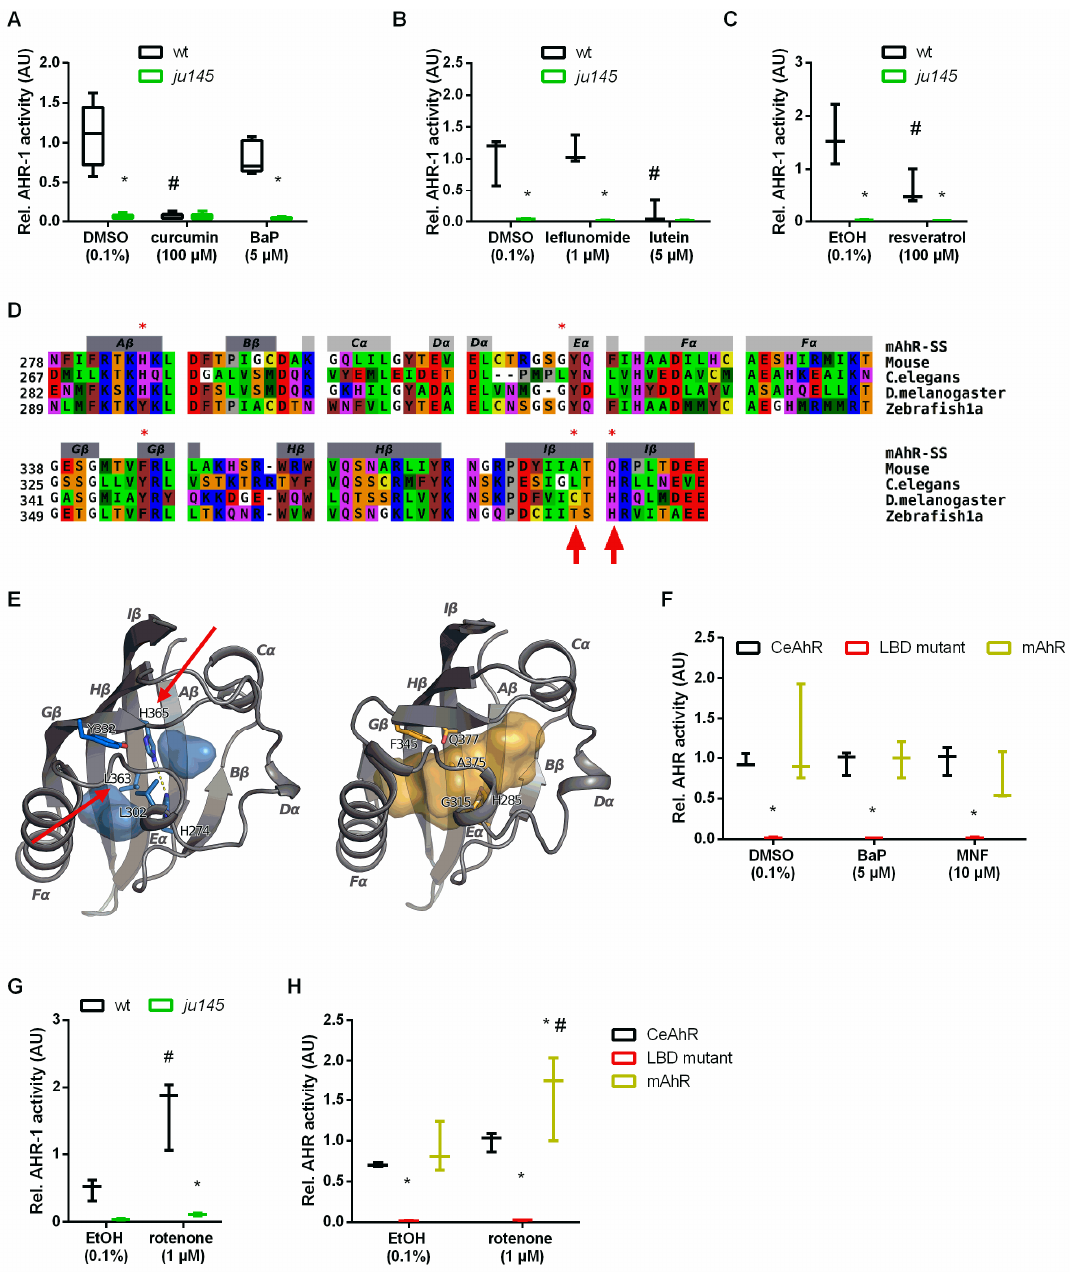
Figure 6. Curcumin and pro-oxidants have opposite effects on AHR-1 activity. ( A – C ) Evaluation of AHR-1 activity after treatment with the indicated compounds in Cos7 cells transfected with either wt AHR-1 (wt) or AHR-1 carrying the ju145 point mutation ( ju145 ) and AHA-1 as well as an XRE- inducible luciferase. Boxplots show data of 3–5 experiments. * p -value < 0.05 vs. wt, # p -value < 0.05 vs. DMSO/EtOH, statistical test: 2-way ANOVA and Tukey’s multiple comparisons test. ( D ) Alignment of the LBDs from C. elegans , Drosophila , and zebrafish AhRs. The color scheme for residues: red, acidic; blue, basic; purple, polar; yellow, Cys; brown, aromatic; green, hydrophobic; orange, Ser, Thr; gray, Pro; white, Gly. ( E ) Secondary structures attributed by DSSPcont to the CeAhR PASB are indicated on top (light gray bars for helices and dark gray bars for β-strands) and labeled according to the PAS domain nomenclature. Asterisks mark the amino acids likely contributing to the inability of CeAhR to bind big ligands. Amino acids highlighted by an arrow were mutated for the investigation of the LBD function (panels F , H ). I 3D models of the CeAhR (left) and the mAhR (right) PASB domains obtained by homology modeling, shown in a cartoon representation. Secondary structures attributed by DSSPcont are labeled according to the PAS domain nomenclature. The colored internal area (blue for CeAhR and yellow for mAhR) defines the molecular surface of the